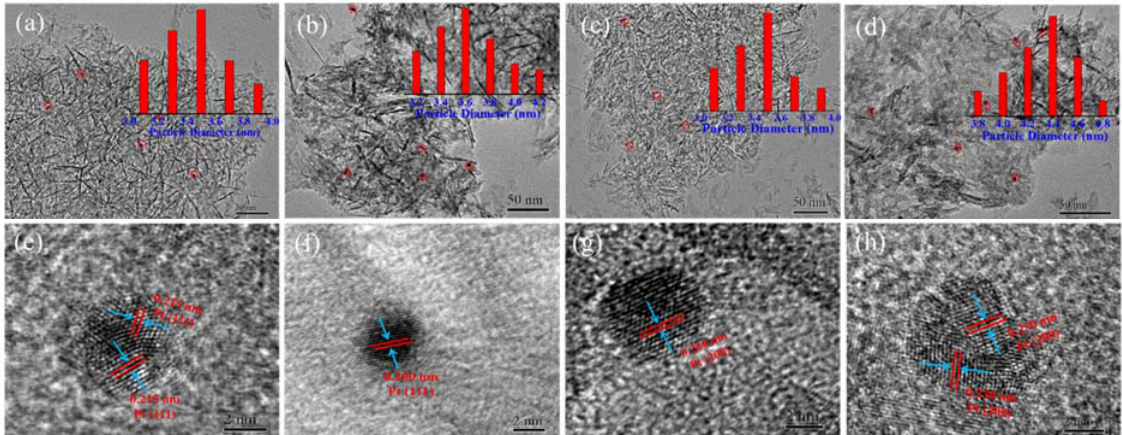
Figure 2. ( a ) Pt/Al 2 O 3 , ( b ) Pt-Ni/Al 2 O 3 , ( c ) Pt-Co/Al 2 O 3 , and ( d ) Pt-Cu/Al 2 O 3 , as well as corresponding to ( e – h ) high-resolution transmission electron microscopy (HRTEM) images in the ( a – d ) TEM images, respectively (insets are the histograms to display the size distributions of Pt-based nanoparticles).